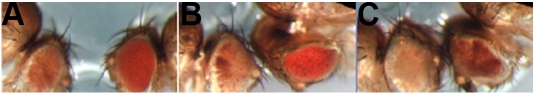
Suppression of PEV.A) Strong (+++) suppression of PEV by Hp1a mutations. w
m4/w
−; +/CyO (left) and a w
m4/w
−; +/Hp1a sibling (right). B) Strong to moderate suppression by an Hp1a deficiency. w
m4/Y; +/CyO (left) and a w
m4/Y
−; +/Df(28E4-7;29B2-C1) sibling (right). C) Moderate (++) suppression by a putative Lamin B Receptor homolog (CG17952) deficiency. w
m4/w
−; +/CyO (left) and a w
m4/w
−; +/Df(57F2;58A1) sibling (right).